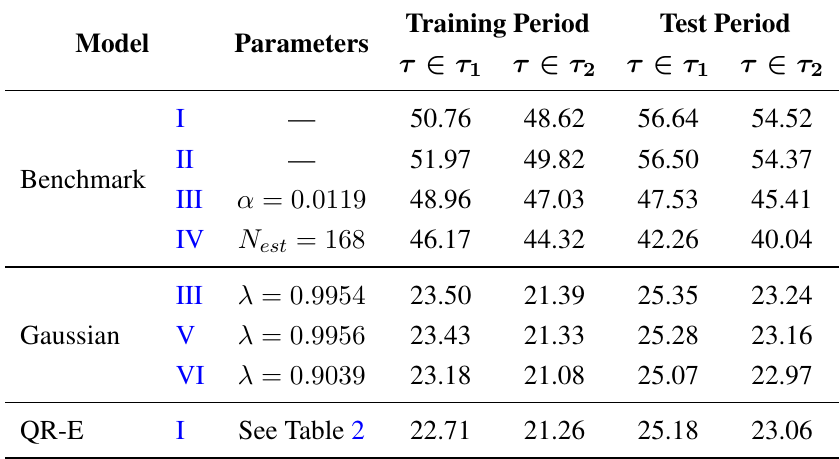
Table 1. The continuous ranked probability score ( CRPS) for the best performing